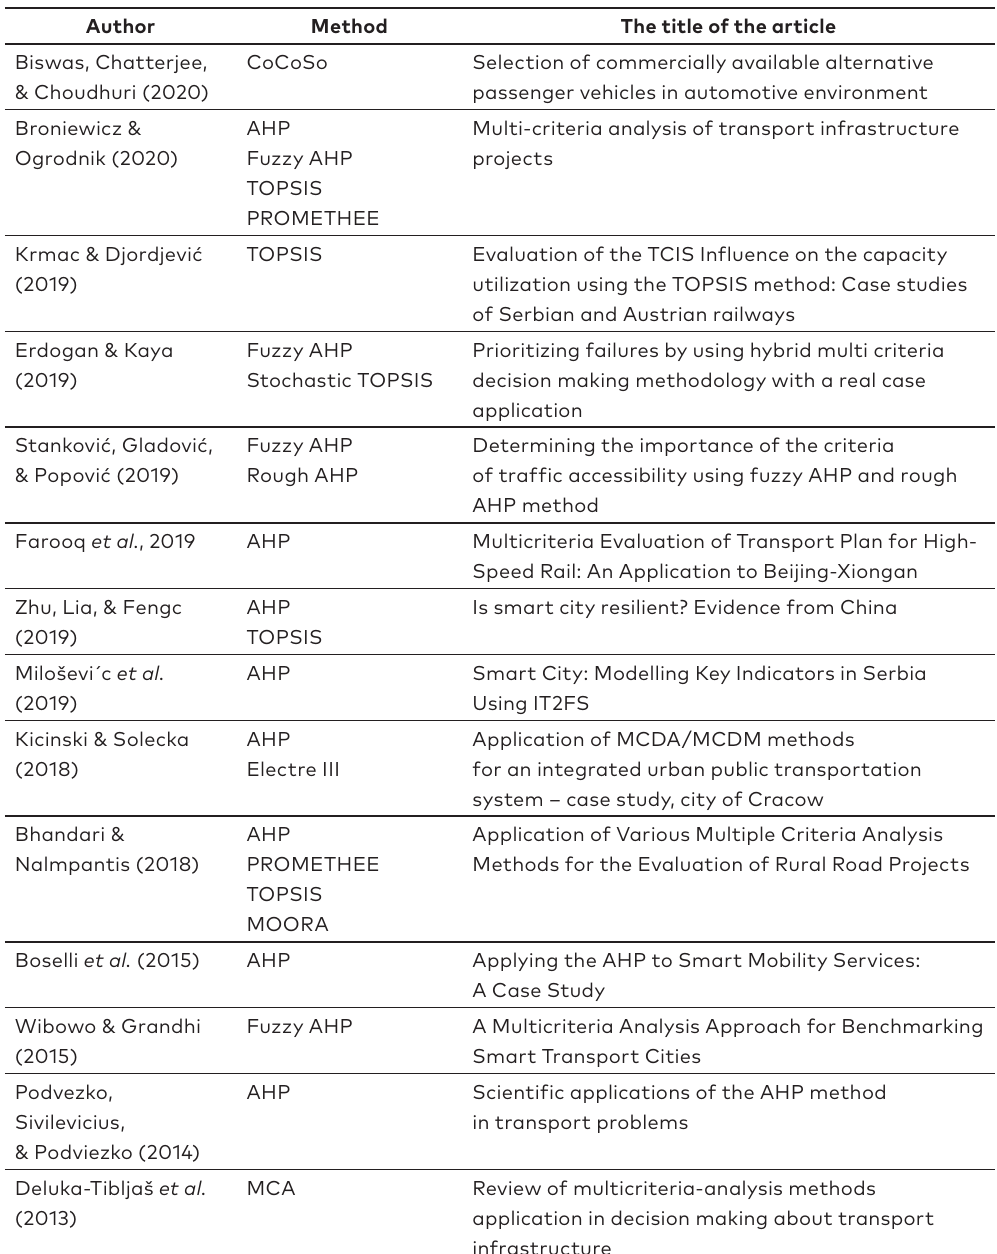
Table 3. Various MCDM methods used by